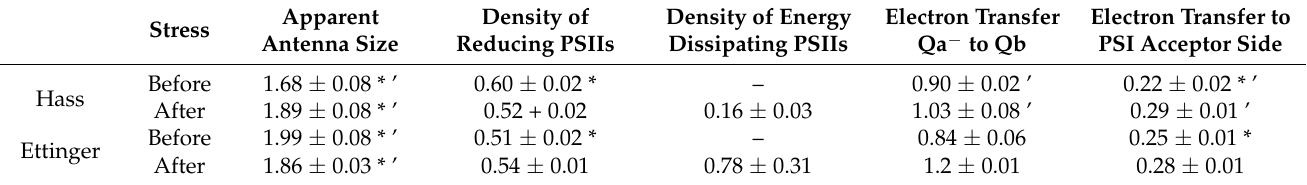
Table 1. Analyzed parameters of the fluorescence transient curve for two cultivars of avocado right before and right after frost stress. N = 6, error represents standard error of the mean.